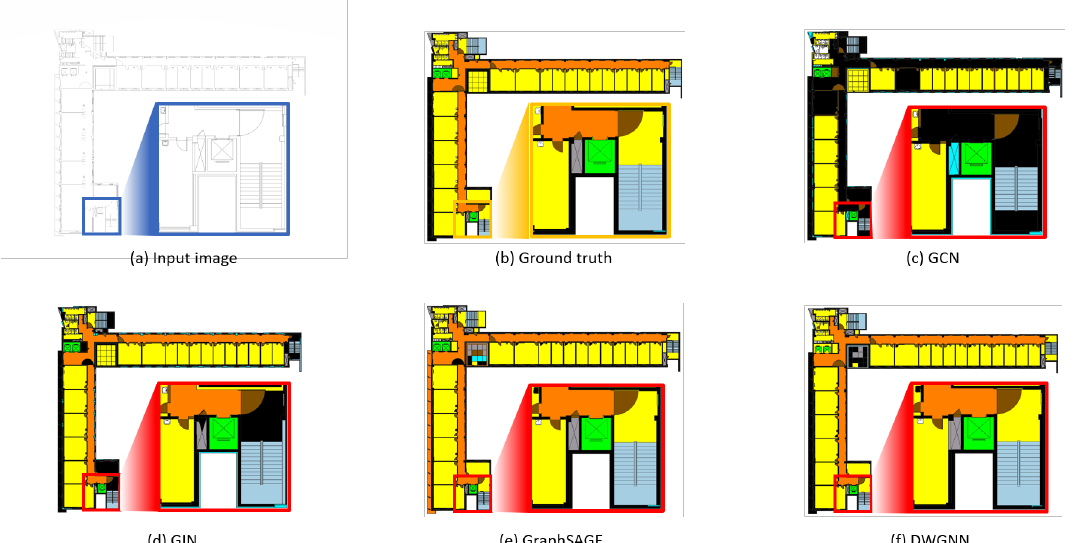
Figure 6. Visualized results of classification on UOS